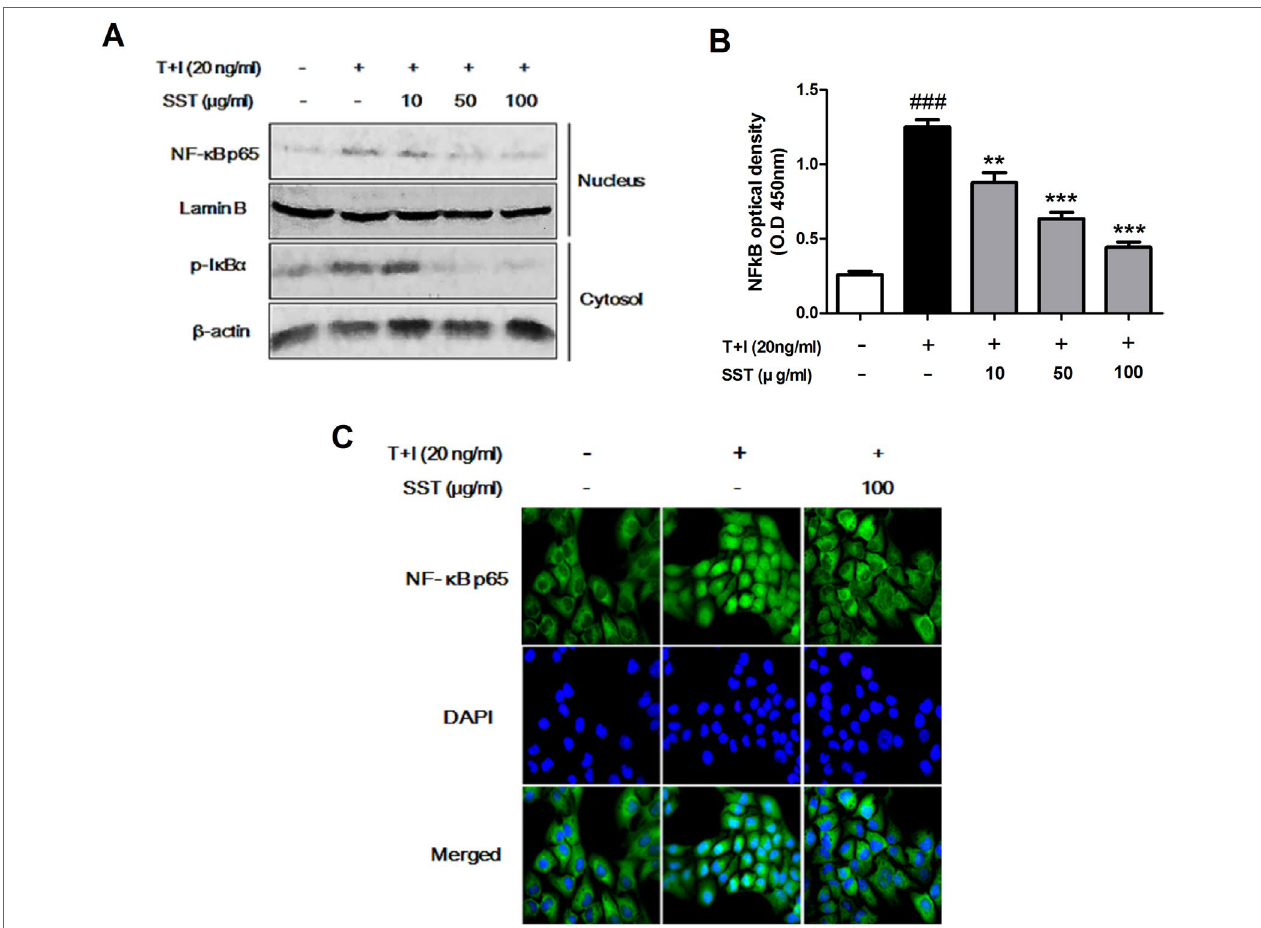
FIGURE 5 | Effects of SST on the nuclear translocation of NF- κ B induced by TNF- α /IFN- γ . HaCaT cells were pretreated with the various concentrations of SST for 15 min and then stimulated with TNF- α /IFN- γ for 30 min. The levels of p-I κ B α protein in cytosol and NF- κ B protein present in the nucleus were examined using western blotting (A) . The expression of NF- κ B p65 in serum-starved HaCaT cells was observed by immunofluorescence microscopy. Representative images from three independent experiments were displayed (B) . Nuclear extracts were analyzed for NF- κ B activation by NF- κ B transcription factor analysis (C) . The data are shown as mean ± SEM of triplicate experiment. ### p < 0.001 vs. no-treatment condition, **p < 0.01, or ***p < 0.001 vs. only TNF- α /IFN- γ treatment